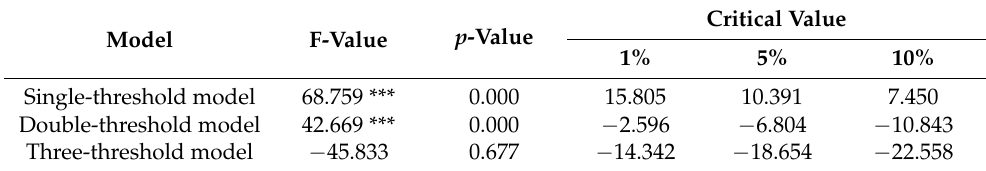
Table 7. Test results of threshold